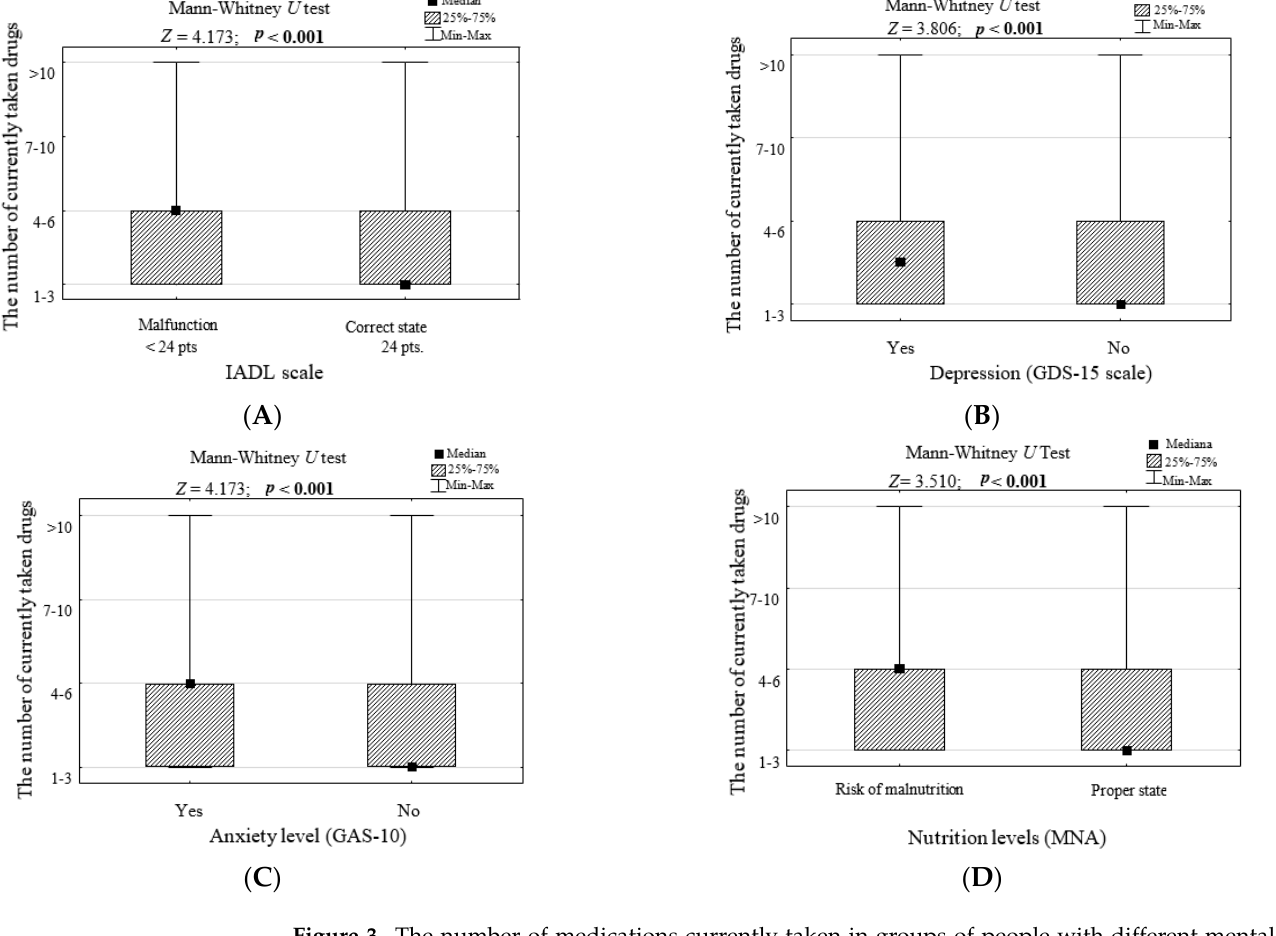
Figure 3. The number of medications currently taken in groups of people with different mental characteristics including ( A ) the assessment of complex activities in daily living, ( B ) depression, ( C ) the level of anxiety, ( D ) the level of malnutrition and the results of significance tests. Including data regarding sociodemographic, clinical, and mental characteristics of elderly patients, we found that independent predictors of taking a large number of medica- tions per day (over 3) were (1) the presence of coronary artery disease (CAD), (2) diabetes (DM), (3) asthma (AST), (4) heart failure (HF), (5) BMI > 25.9 kg/m 2 and (6) gastroe- sophageal reflux disease (GERD) (Table 4). The likelihood of taking more than three medicines per day increases approximately seven times when patients had coronary artery disease (OR = 6.77; CI 95%, 2.86–16.1). Furthermore, patients with BMI > 25,9 kg/m 2 BMI < 25,9 kg/m 2 (OR = 2.68, CI 95%, 1.50–4.77). Moreover, the significant correlation